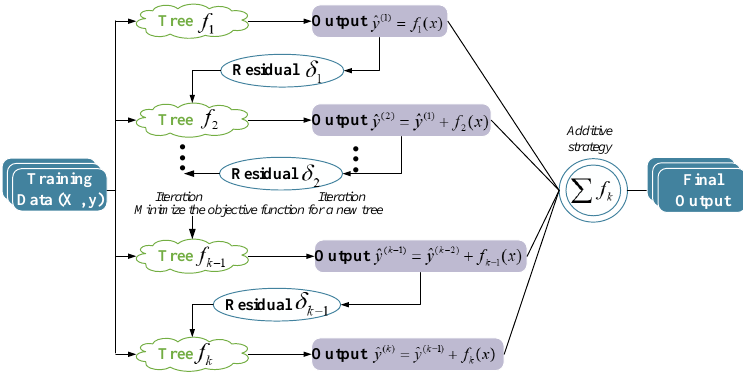
Figure 3. The structure of extreme gradient